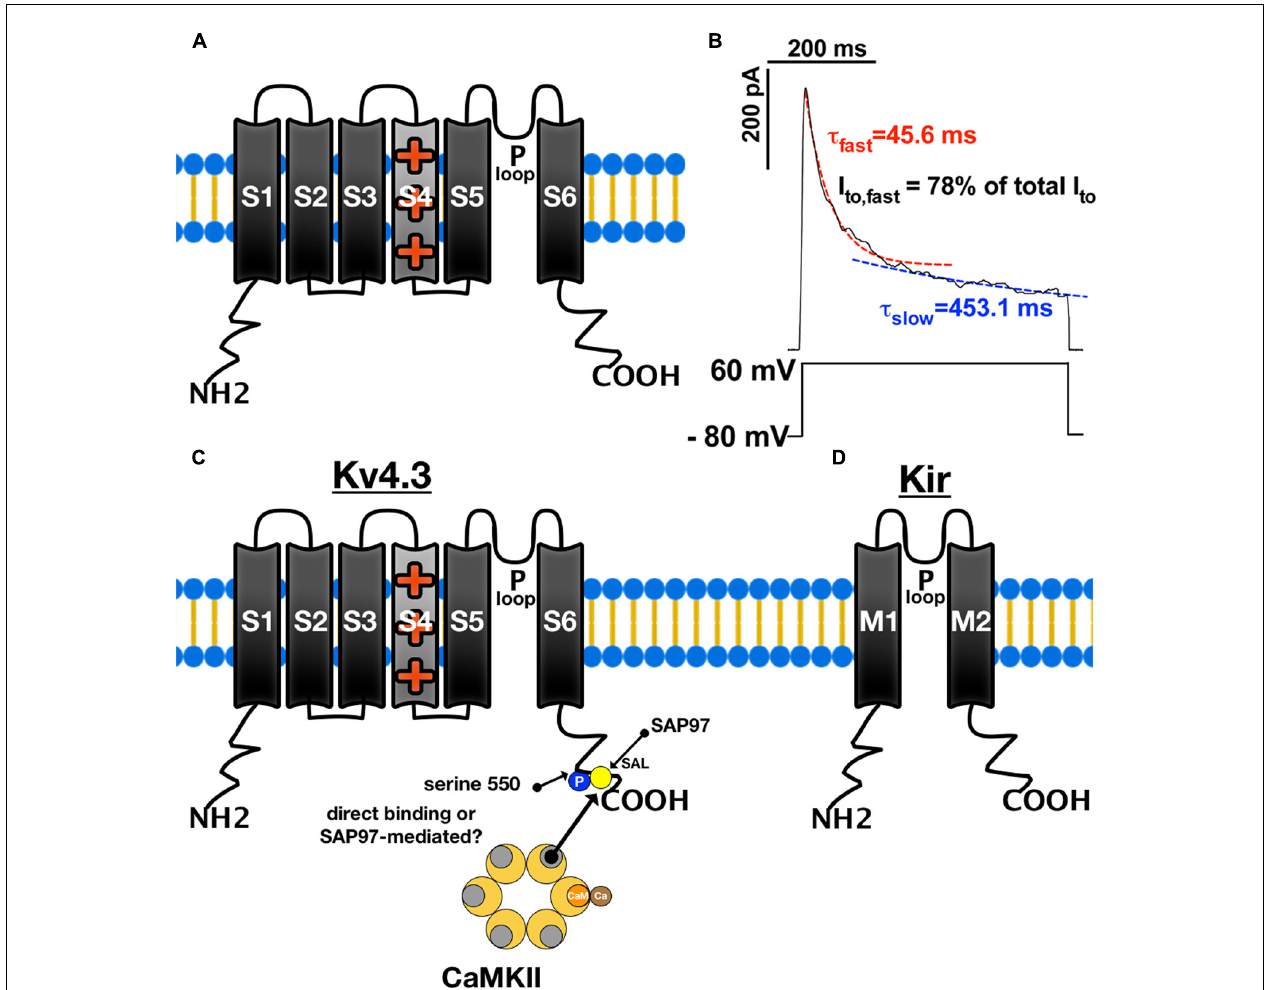
FIGURE 2 | Structure and function of K channels. (A) Structure of voltage-gated K channel α -sunbunit (Kv) with six transmembrane segments (S1–S6).The S5–S6 segments face each other to form the central pore.The P-loop between the S5 and S6 segments acts as an ion conductance pathway and its signature motif G(Y/F)G functions as a K ion selectivity filter. Segment S4 senses voltage and moves outward during cell membrane depolarization resulting in conformational changes which open the pore. (B) There are two current components of I to generated that can be distinguished according to